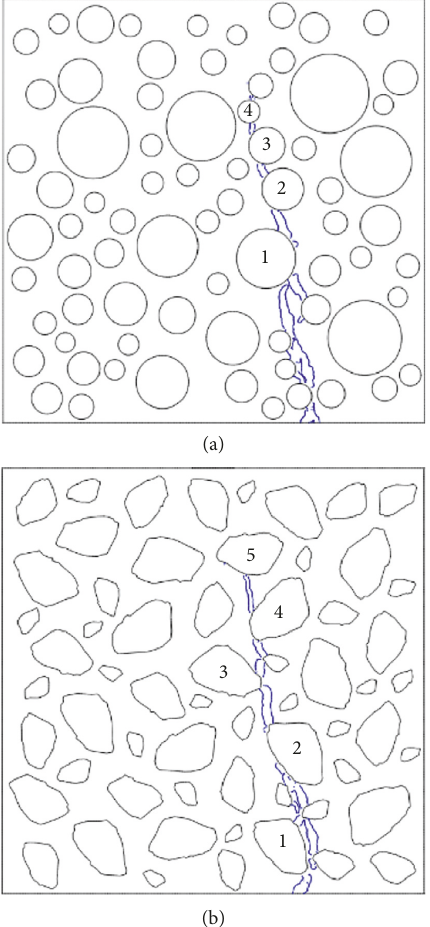
Figure 15: Three-point bending concrete beam crack distribution. (a) Circle aggregate model. (b) Actual aggregate